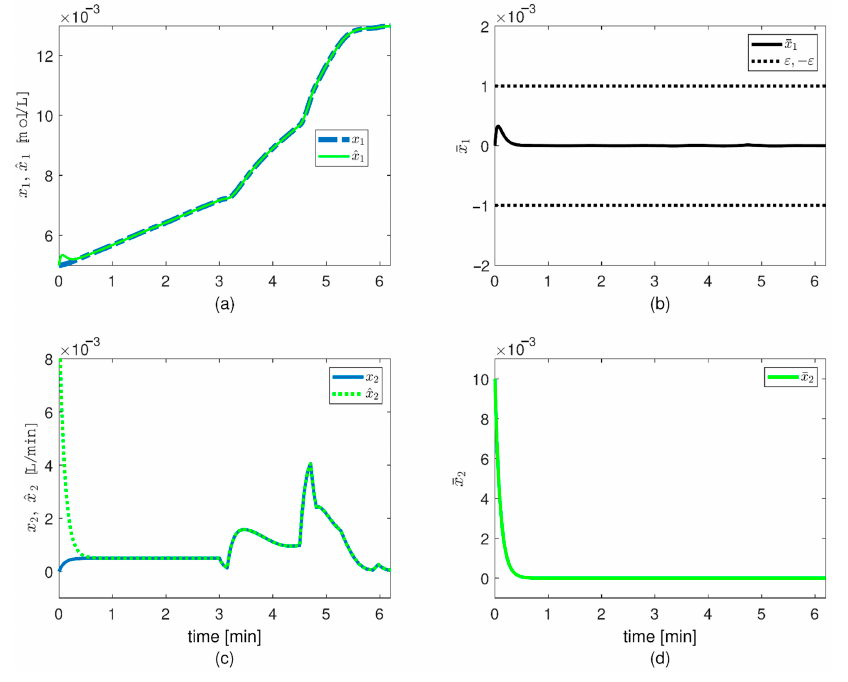
Figure 2. Observer simulations for the first case. ( a ) Time course of the state x 1 and estimated state ˆ x 1 . ( b ) Time course of the observation error x 1 = ˆ x 1 − x 1 . ( c ) Time course of the state x 2 and estimated state ˆ x 2 . ( d ) Time course of the observation error x 2 = ˆ x 2 − x 2